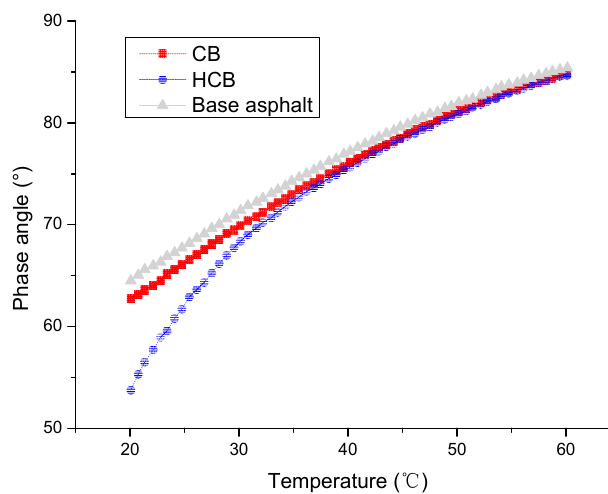
Figure 6. Effect of CB and HCB on complex shear modulus of asphalt.